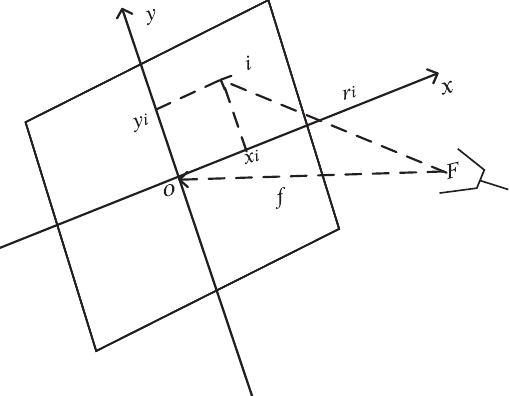
Figure 4. Schematic diagram of the phase distribution at position i .